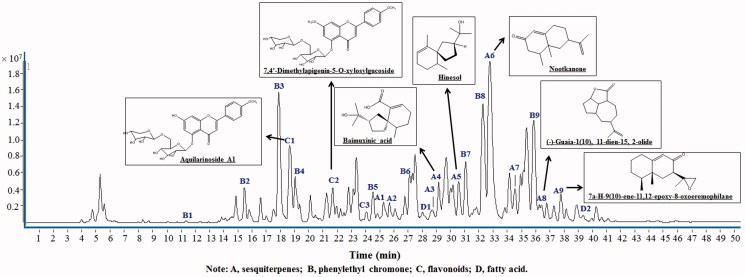
The UHPLC-Q-TOF-MS chromatograms of ALR methanol extracts.